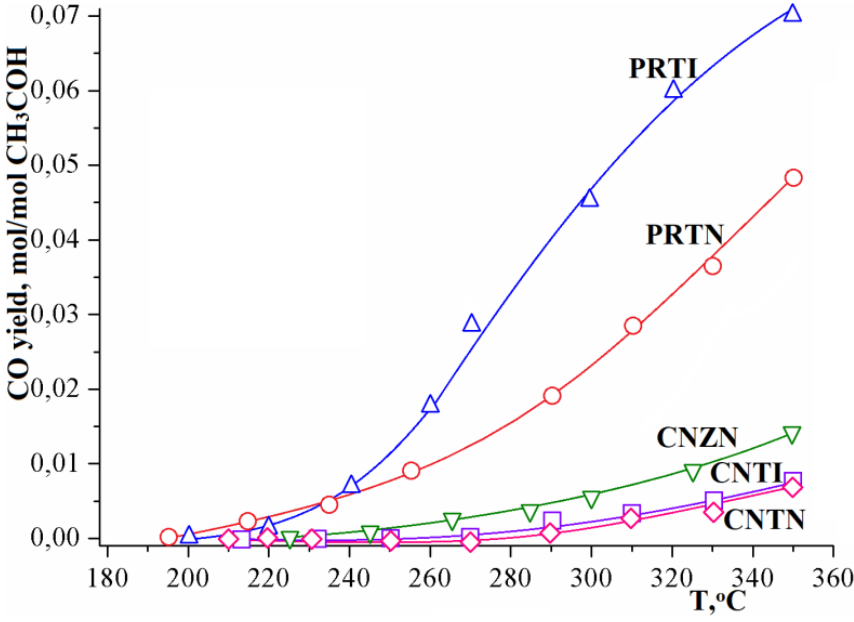
Figure 6. Temperature dependence of CO yield in the methanol–water (1:1) system using various catalysts.